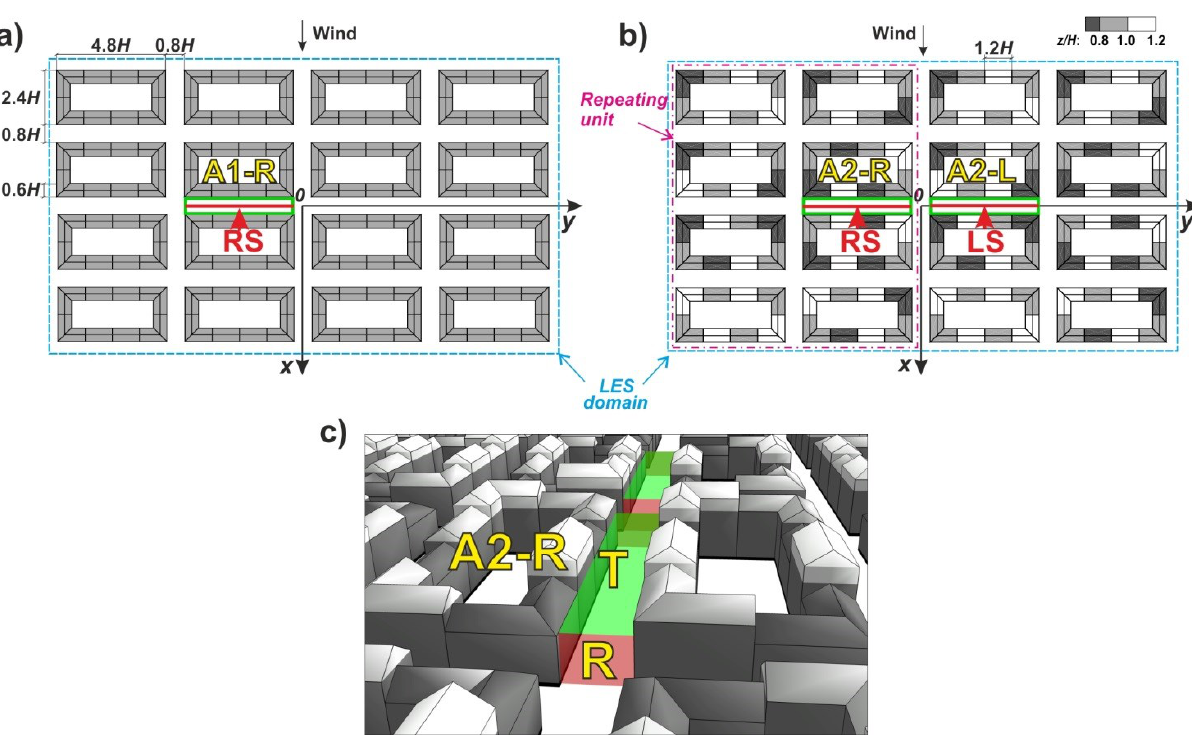
Fig. 1 .Schemes of modelled urban areas with the investigated street canyons: a) top view of the uniform urban-array model A1 and b) top view of the non-uniform urban-array model A2, where the green rectangles and red lines mark the investigated canyons (A1-R, A2-R, A2-L) and the pollution source position (RS, LS), respectively. c) 3D view of model A2, where the red and green planes represent the lateral and top openings of the investigated non-uniform canyons, respectively. The grey contour represents the dimensionless height (z/H) ([13]; partly modified by the present